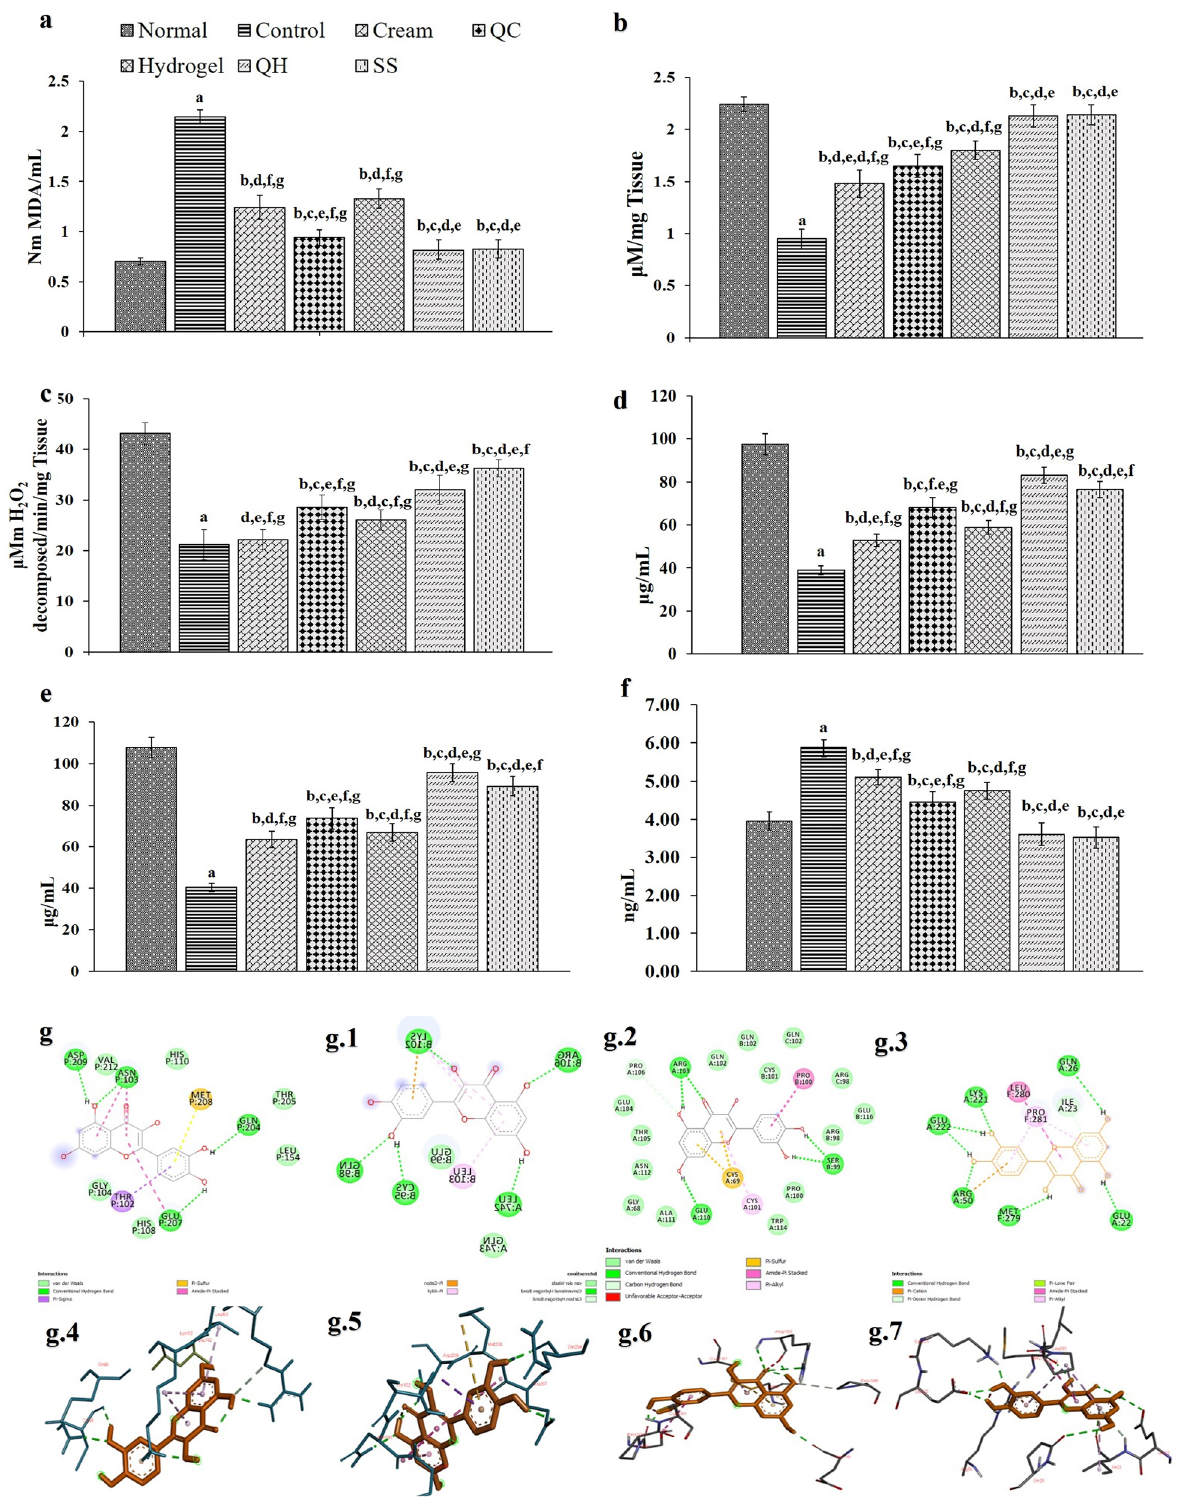
Figure 6. In vivo wound healing changes in ( a ) MDA; ( b ) GSH; ( c ) CAT; ( d ) HXP; ( e ) HXA and ( f ) NF-κB levels of the Normal, Control, cream base group (Cream), quercetin loaded cream (QC), GbH base (Hydrogel), quercetin loaded GbH (QH) and silver sulfadiazine (SS) treated groups. The results are represented as the mean ± S.D. with n = 6 in each group a p < 0.05 as compared to the Normal group; b p < 0.05, as compared to Control group; c p < 0.05, as compared to Cream group, d p < 0.05, as compared to QC group, e p < 0.05, as compared to Hydrogel group, f p < 0.05, as compared to QH group, g p < 0.05, as compared to SS group. 2-D and 3-D image of quercetin interaction with: ( g ) and ( g.4 ) 1SVC target interaction; ( g.1 ) and ( g.5 ) 3BRV target interaction; ( g.2 ) and ( g.6 ) 1NFI target interaction, and ( g.3 ) and ( g.7 ) 2E7A target